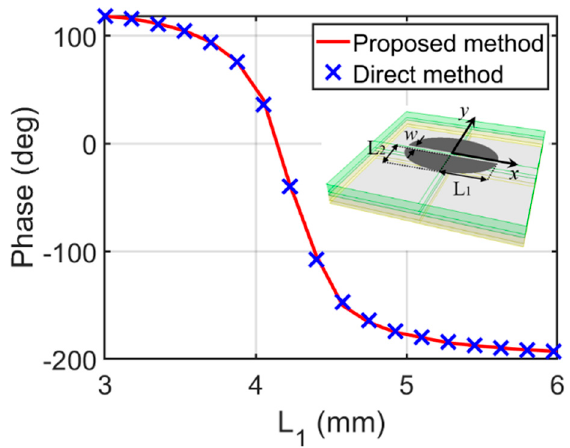
Figure 8. Phase curves of the copolar reflection coefficient for transverse magnetic polarized incident wave for the unit shown in Figure 3 at 10 GHz under oblique incidence θ inc = 20 deg and φ inc = 0 deg for variation of the L 1 parameter.